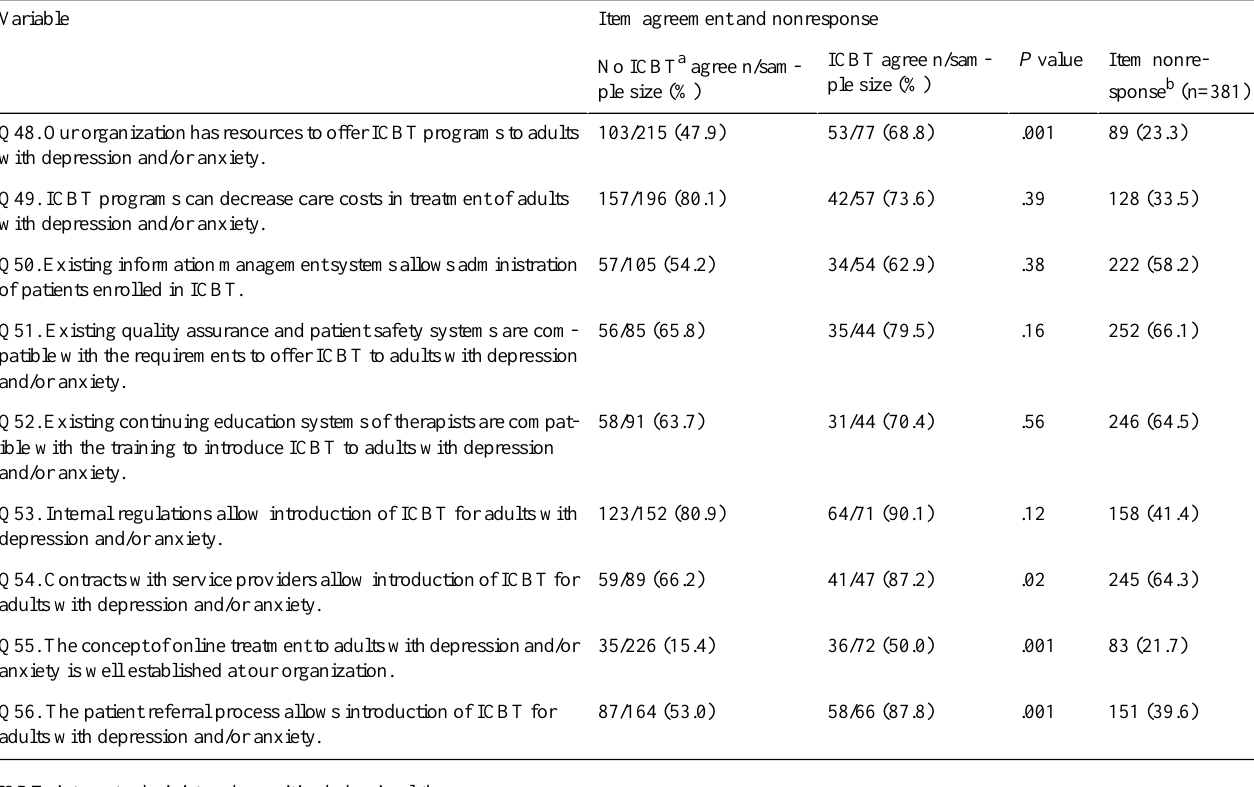
Table 5. Implementers and nonimplementers agreeing to organization-related items.